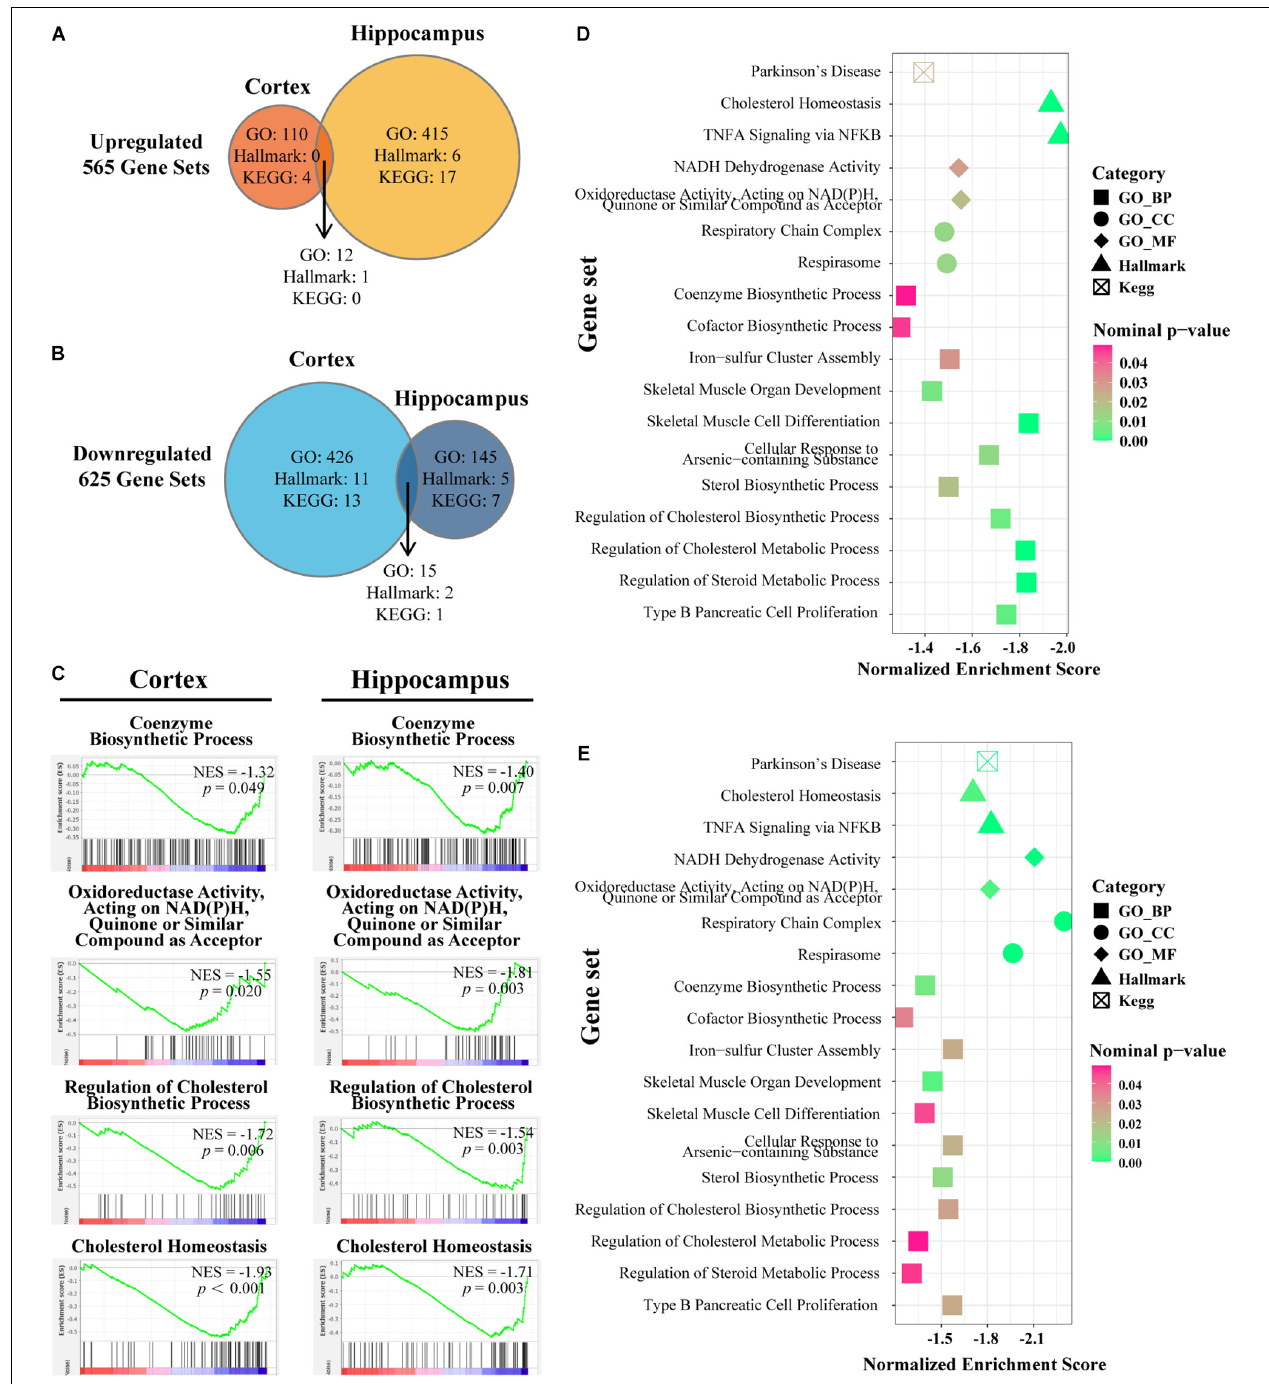
FIGURE 4 | Gene set enrichment analyses in cortex and hippocampus and the intersection of the enriched pathways. (A,B) Venn diagram depicts the amount of significantly up-/downregulated pathways with nominal p -value < 0.05 in the cortex or hippocampus of IL15R α − / − samples. Enriched pathways are retrieved from following sets of genes: H (Hallmark gene sets), KEGG (KEGG subset of CP), BP (GO biological process), CC (GO cellular component), and MF (GO molecular function). Overlapped areas in the diagram count the commonly contributing pathways in both cortex and hippocampus. (C) Enrichment plot provides a graphical view of the enrichment score for pathways chosen from downregulated overlapped pathways. (D) Bubble diagram conveys the core characters of certain pathways in cortex. (E) Bubble diagram presents the state of certain pathways in hippocampus. The shape, color, and abscissa value of points indicate the category of gene sets, magnitude of nominal p -value, and normalized enrichment score, respectively. Pathways are selected from overlapped downregulation.